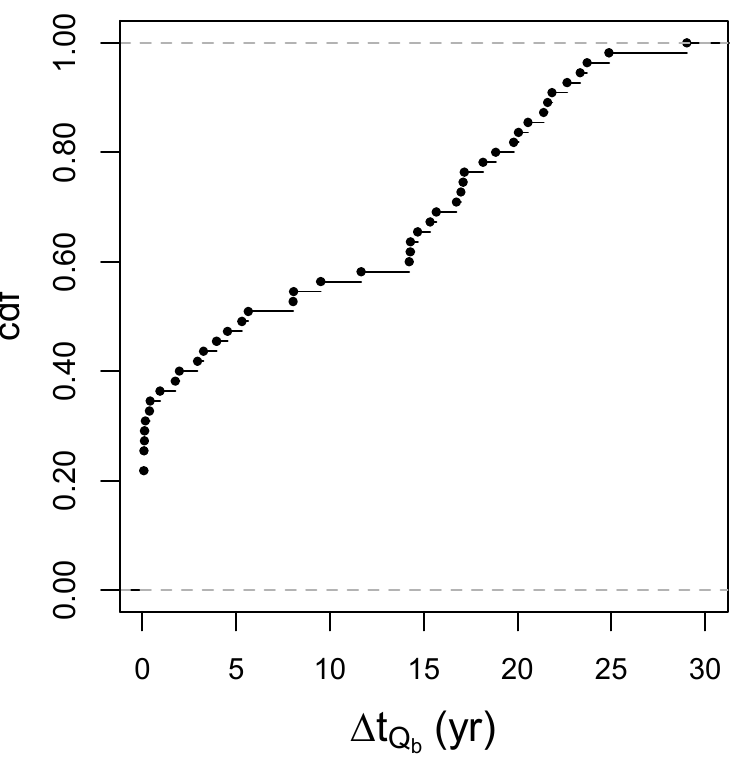
Figure 3. Cumulative distribution (CDF) of mean ∆ t between R and Q b for all 55 basins with saltwater presence, with 36% showing ∆𝑡 < 1 year and the remaining 64% between 1–30 years.